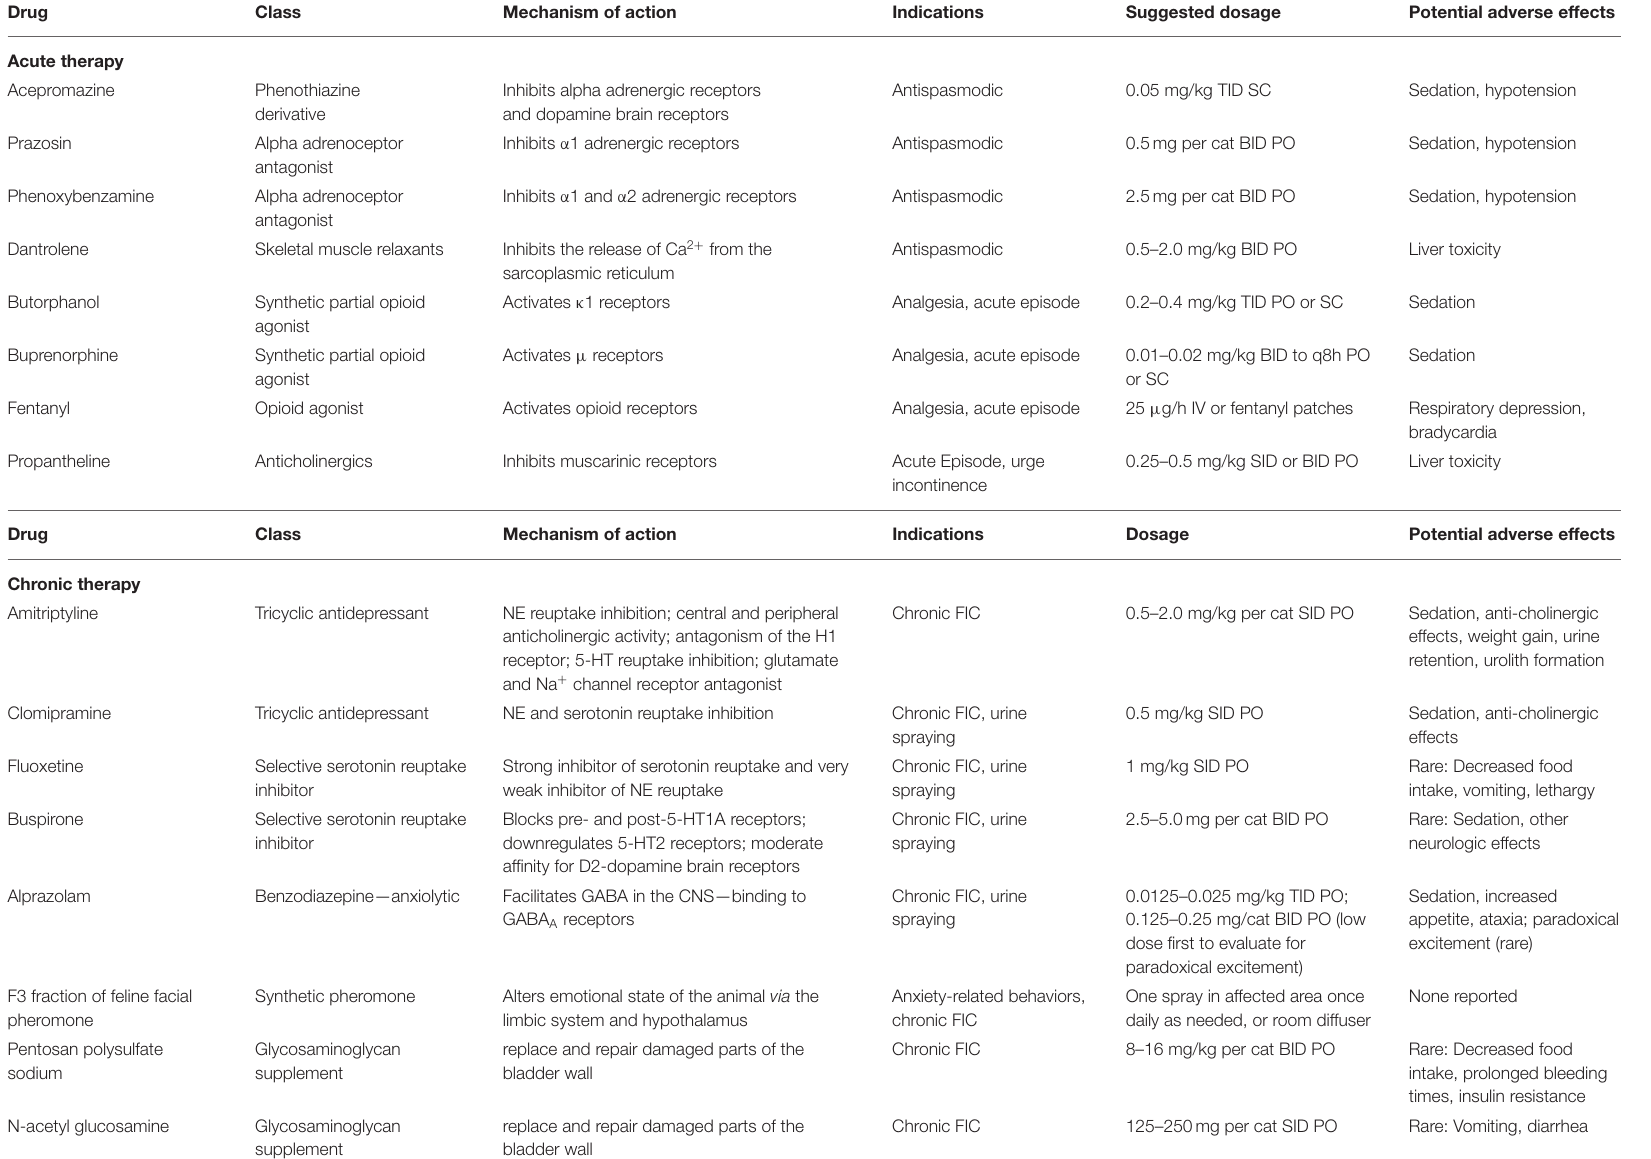
TABLE 1 | Drugs used in the management of FIC [adapted from Chew et al.